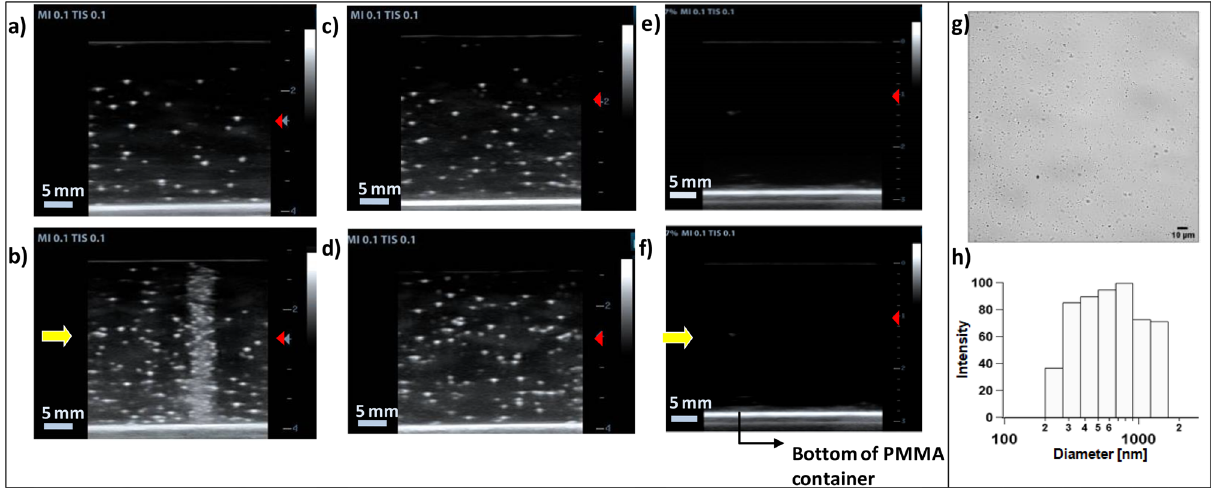
Figure 2. Ultrasound images of PVA/PFB NDs dispersed in PAM phantom (4 × 10 6 ND/ml) before ( a ) and after ( b ) exposure to 312 MeV/u C-ions (4 Gy dose, 180 mm range). Corresponding images for a control phantom with dispersed PVA/PFB NDs before ( c ) and after ( d ) incubation at 37 °C (i.e. without irradiation). US images of control phantom made of pure PAM without NDs before ( e ) and after ( f ) at identical irradiation conditions. The images are acquired at 7.5 MHz with MI = 0.1. The yellow arrows indicate the beam entrance side, The red triangles indicate the US focal depth. ( g ) Oil immersion optical microscopy image of PVA/PFB NDs (objective 60 ×). ( h ) Size distribution of the nanodroplets by intensity-weighted dynamic light